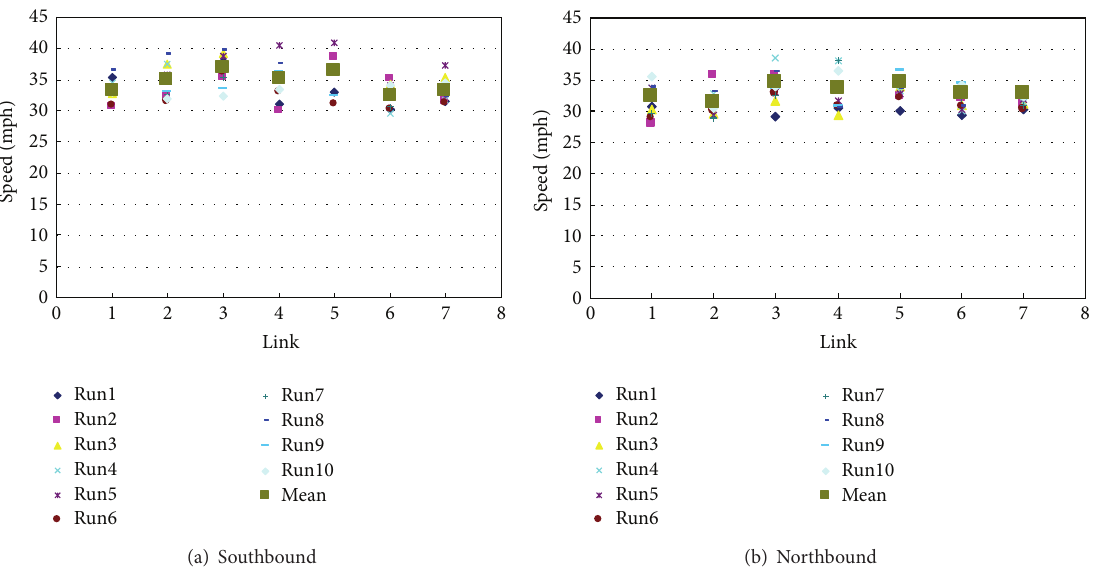
Figure 8: Average practical travel speeds for links.